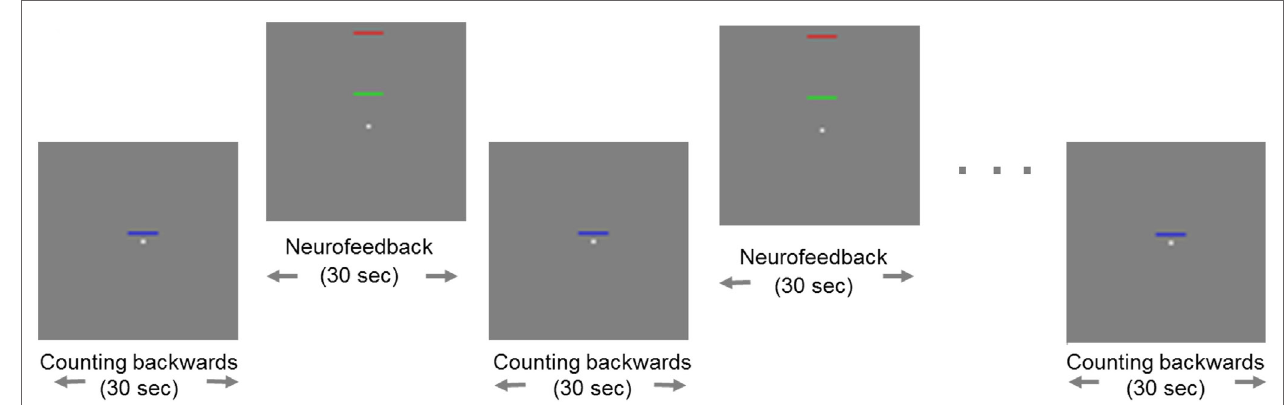
FIGURe 1 | example of a neurofeedback run . Blocks of regulation alternated with blocks of baseline (“counting”). During regulation blocks, the fixed red bar in the upper part of the screen served as a marker of the highest ACC activity as a target. The green moving bar indicated the current level of activity in the ACC, which should be moved toward the red bar. The baseline block was indicated by a static blue bar in the center of the